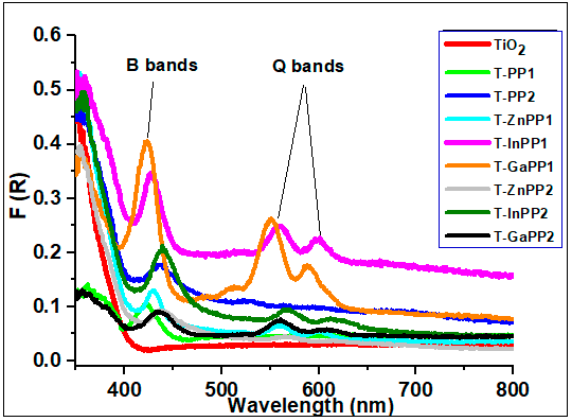
Figure 5. Diffuse Reflectance spectra of the P -TiO 2 photocatalysts.